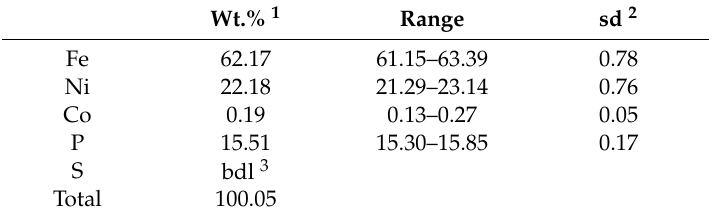
Table 2. Chemical composition of schreibersite from troilite nodules of the Augustinovka meteorite.